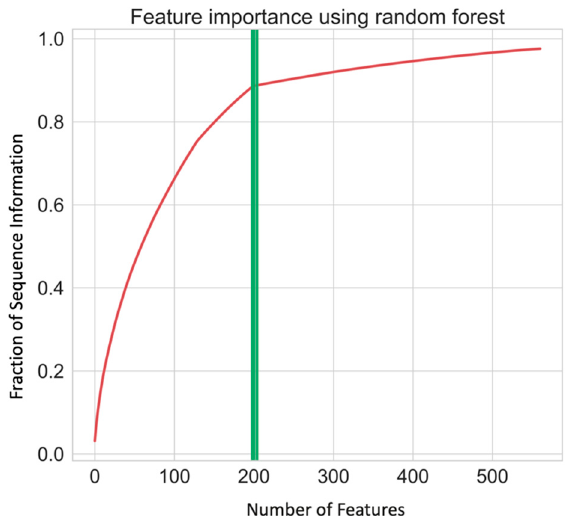
Figure 2. The fraction of peptide information available in 561 features is shown as a function of the number of features. The top 200 features were used in this work, and they represent ~90% of the available information. The addition of 100 more features only adds